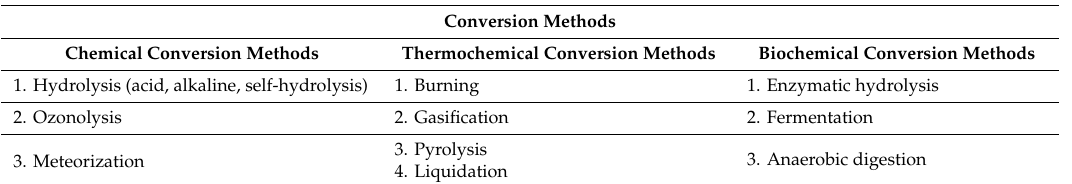
Table 2. Biomass conversion methods